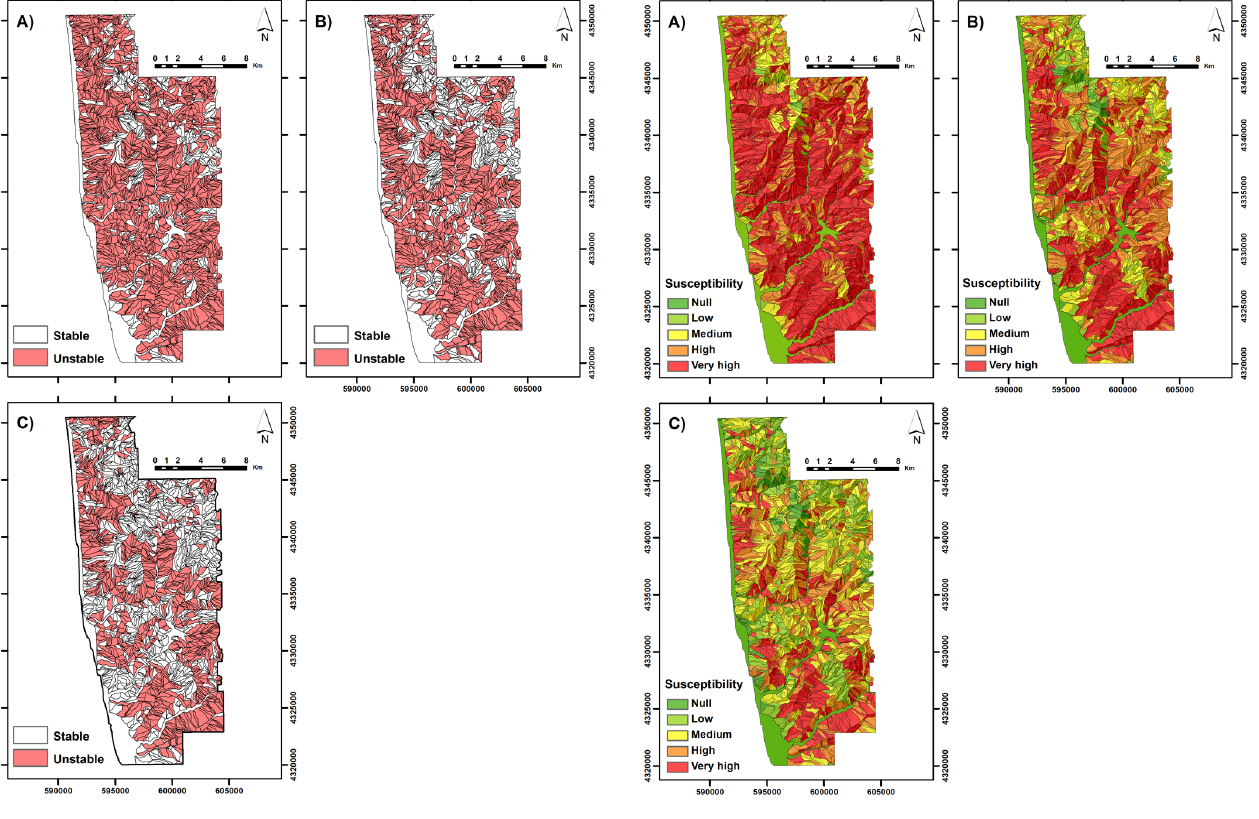
Fig. 10. Susceptibility maps obtained with slope units and dummy variables for tested landslide frequency threshold (Lft): (A) Lft > 5%; (B) Lft > 20%; (C) Lft >